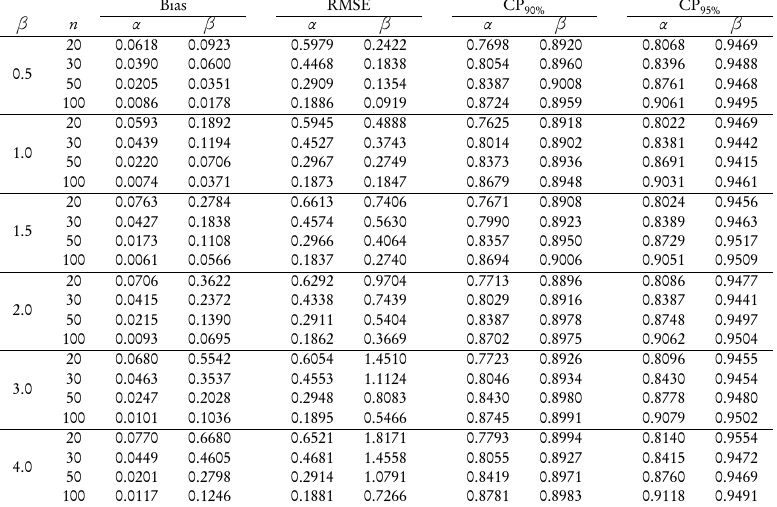
Estimated bias, root mean-squared and coverage probability α and β ( α = 0.5 ).